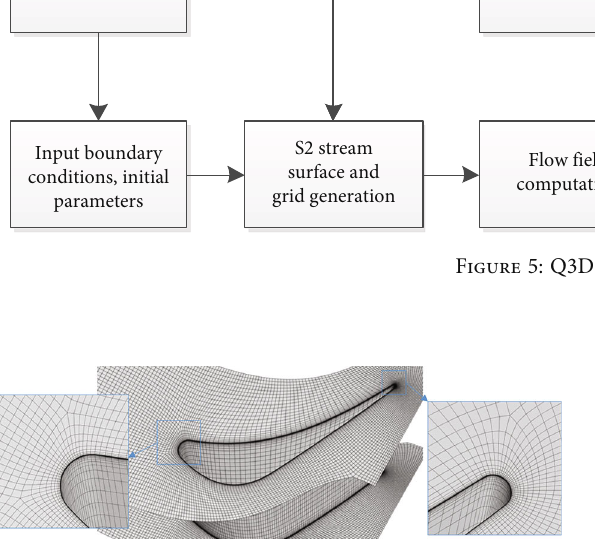
Figure 6: 3D computational grid in blade